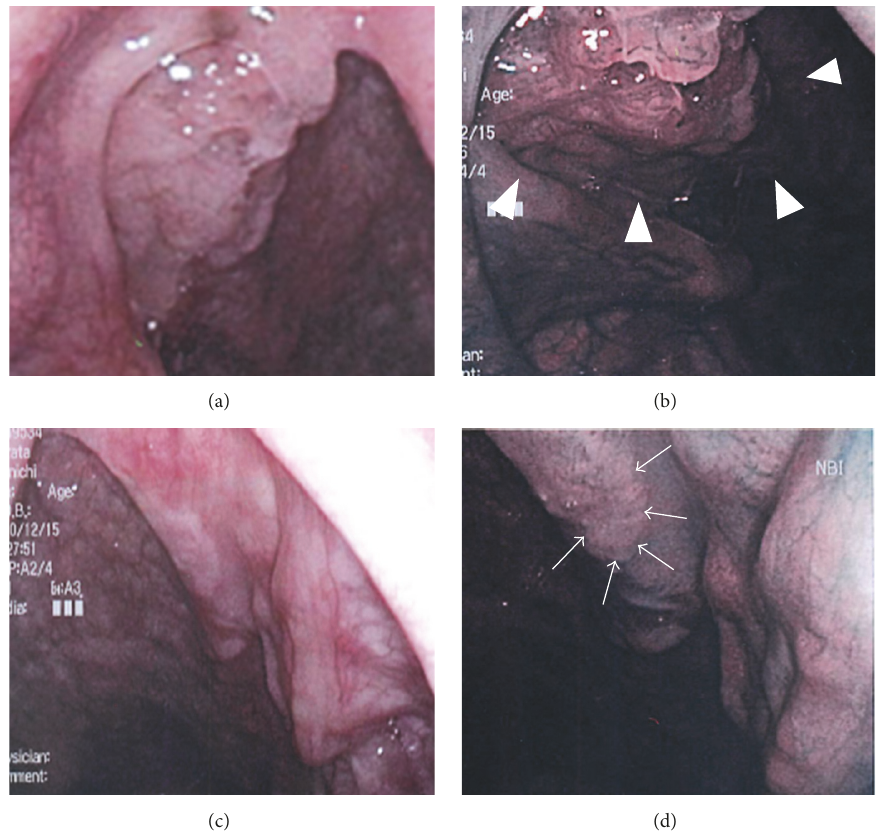
Figure 1: Endoscopic findings of palatine tonsils. The lesion could not be clearly visualized using conventional endoscopy ((a) right tonsil; (c) left tonsil). NBI enhanced an irregular surface and abnormal vascular proliferation ((b) right tonsil; (d) left tonsil).